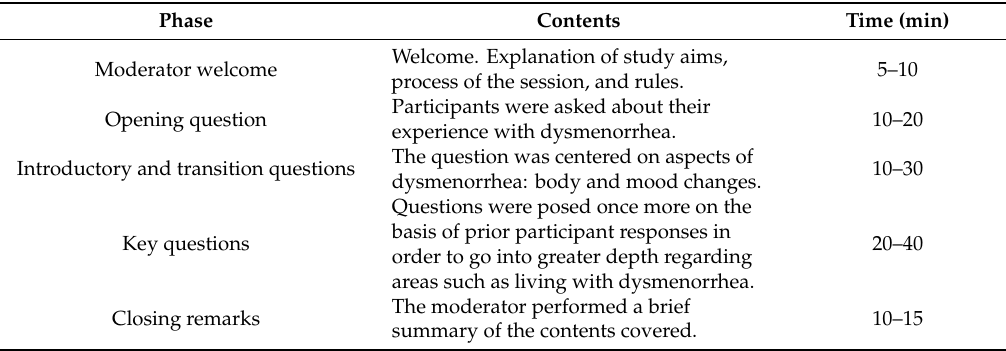
Table 2. Focus groups structure.